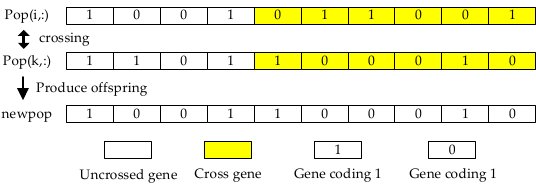
Figure 5. Chromosome crossover was performed between the original nectar source and a nearby nectar source.